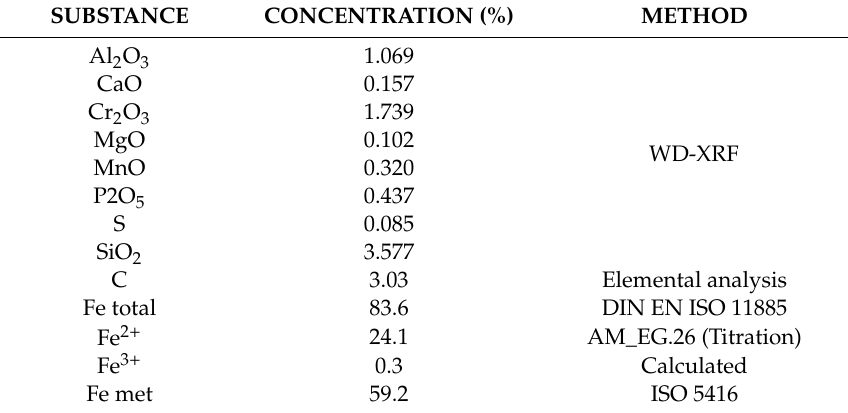
Figure 1. Picture ( a ) and stereo-micrograph ( b ) of grinding sludge samples. Table 1. Chemical analysis of grinding sludge samples.